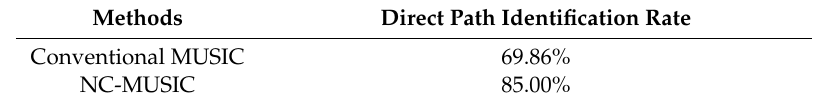
Figure 9. ( a ) CDF of the NC-MUSIC and conventional MUSIC ranging error in UMi scenario. ( b ) CDF of the NC-MUSIC and conventional MUSIC ranging error in UMa scenario. Table 7. Direct path identification rate of NC-MUSIC and conventional MUSIC in UMi scenario.